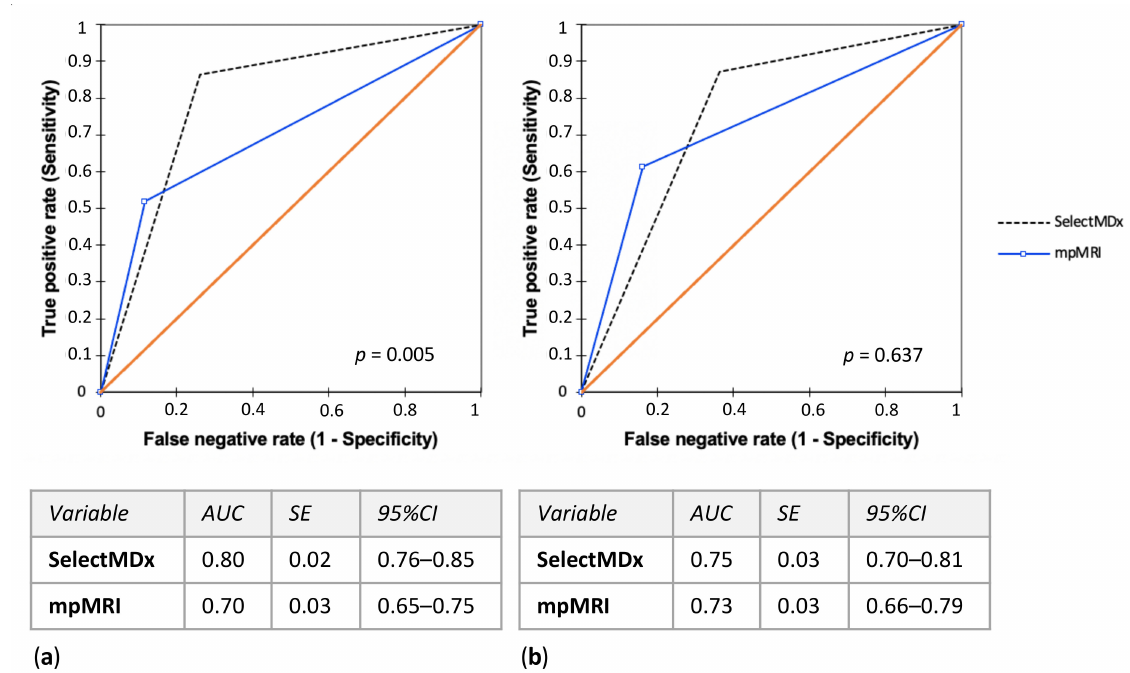
Figure 2. SelectMDx score and mpMRI PI-RADS score performance evaluated as area under the curve (AUC) of the receiver operating characteristics (ROC) in predicting ( a ) PCa and ( b ) csPCa histological diagnosis at biopsy. (mpMRI = multiparametric magnetic resonance imaging; PI-RADS = Prostate Imaging-Reporting and Data System; PCa = prostate cancer; csPCa = clinically significant PCa; AUC = area under the curve; SE = standard error; CI = confidence